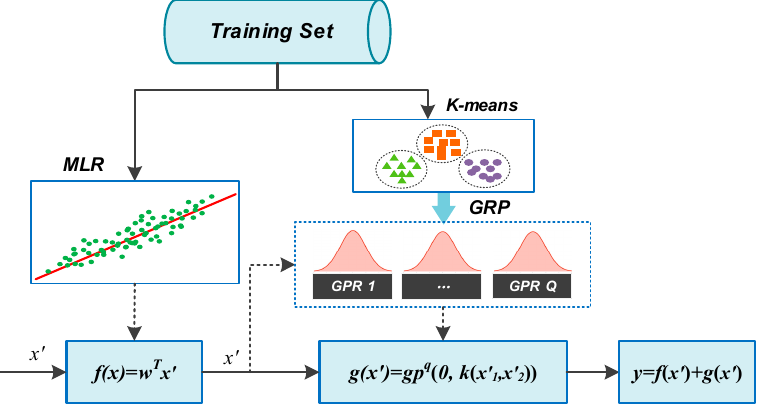
Figure 2. HyGPR model with K-means clustering. MLR: multiple linear regression; GPR: Gaussian process regression.